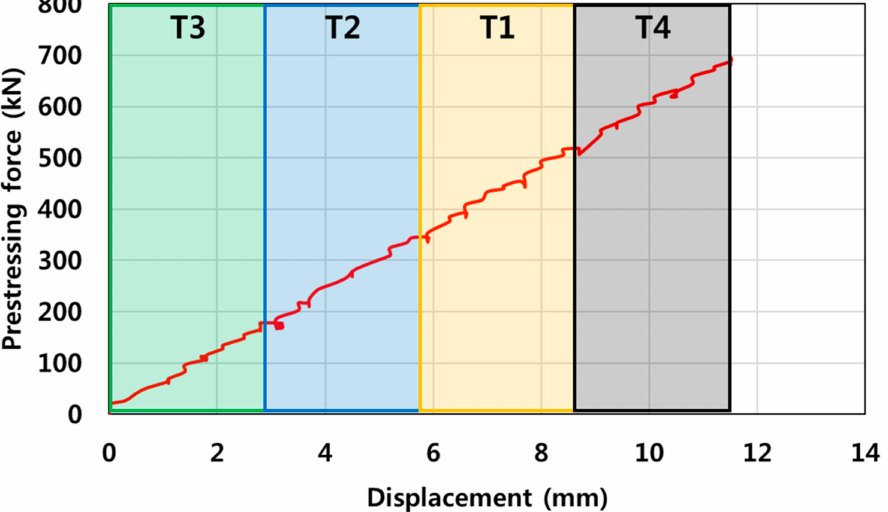
Figure 7. Displacement according to